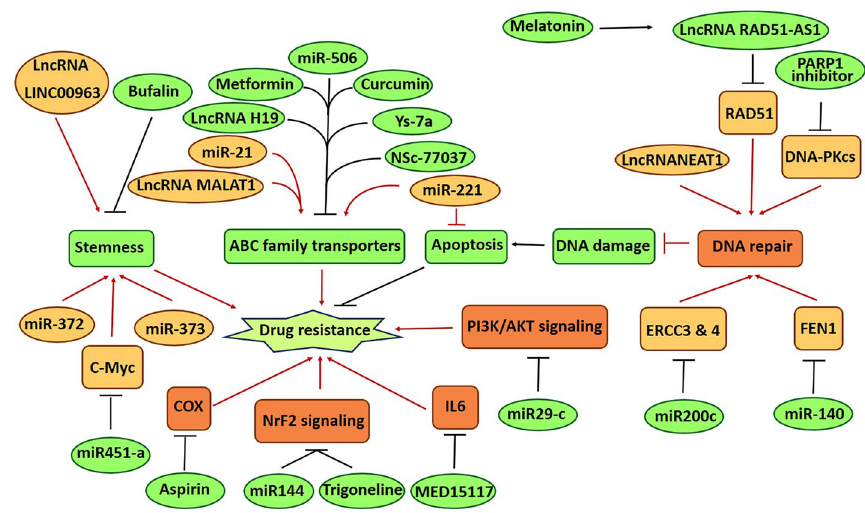
Fig. 1 A summary of new advances in overcoming drug resistance in